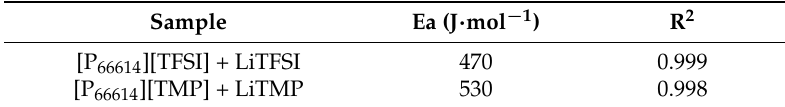
Table 2. Activation energy and correlation coefficients of phosphonium electrolytes.